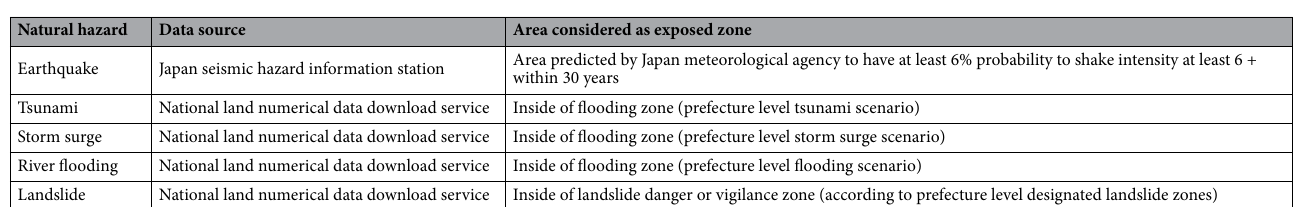
Table 1. The five natural hazards considered in the study with data sources and the areas considered as